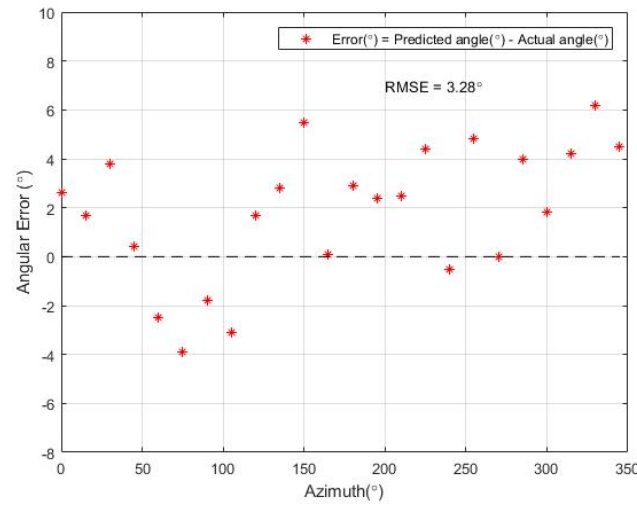
Figure 14. Estimation errors of azimuth for different positions.